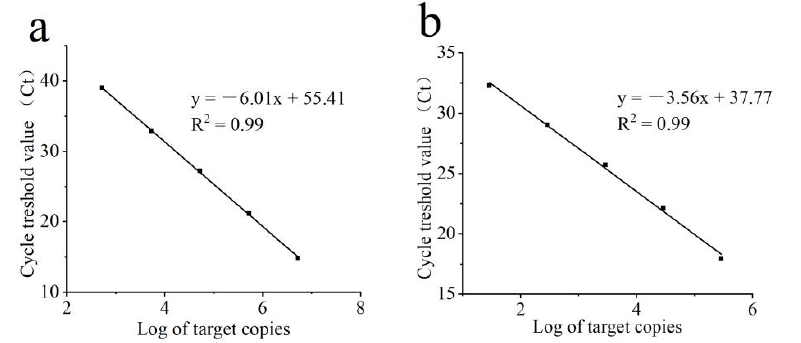
Figure 4. Standard curve of the qPCR for quantification of Botrytis cinerea ( a ) and Clonostachys rosea ( b ). qPCR standard regression was obtained from the log of the copy number of B. cinerea ( a ) and C. rosea ( b ) against the corresponding cycle threshold (Ct) values. Target range was from 5.25 × 10